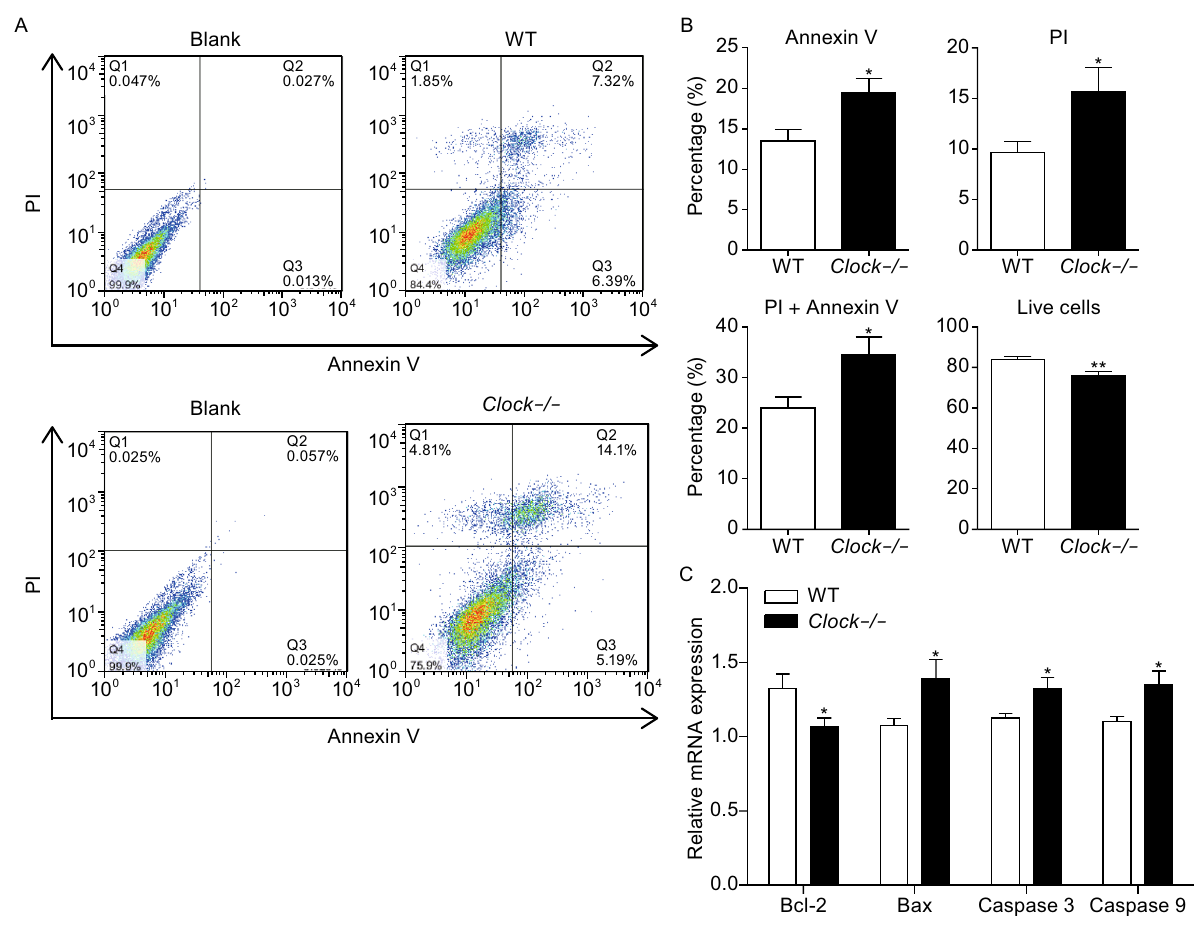
Figure 5. Clock silencing accelerated cell death in mESCs. (A) Apoptosis and overall cell death of the wild type and Clock -/- mESCs were analyzed by fl ow cytometry using the Annexin V and PI assay, respectively. Clock -/- mESCs exhibited increased apoptosis and overall cell death. (B) Percentage of apoptotic (Annexin V) and dead (PI) cells calculated from six independent experiments. Data were expressed as means ± S.D. (C) Relative mRNA expression levels of apoptosis-related genes Bax, Bcl-2, cleaved caspase-3 , and caspase-9 in wild type and Clock -/- mESCs. The mRNA expression levels were normalized to that of the endogenous GAPDH . Data represent the average of three independent experiments and are expressed as means ± S.D.